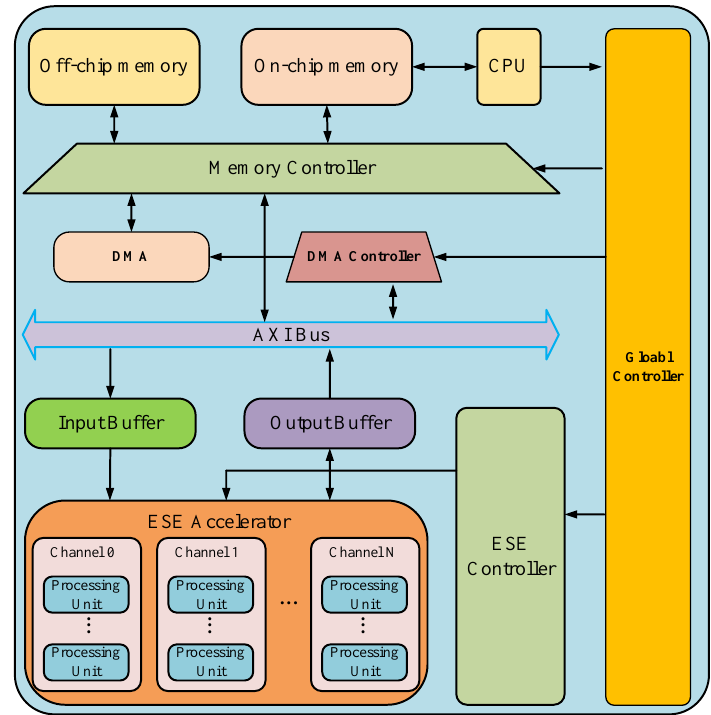
Figure 18. ESE system architecture.